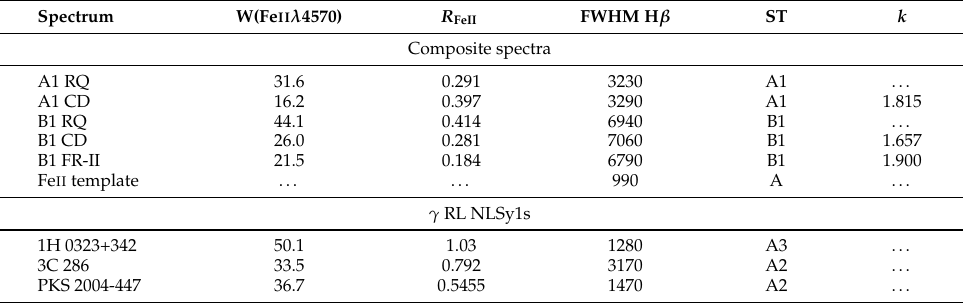
Figure 4. In the left panel, comparison between RQ and CD composites of spectral type B1. In the right panel, comparison between B1 RQ, the same as in the left panel, and B1 FR-II. Bottom panels as in Figure 3. Table 1. Basic